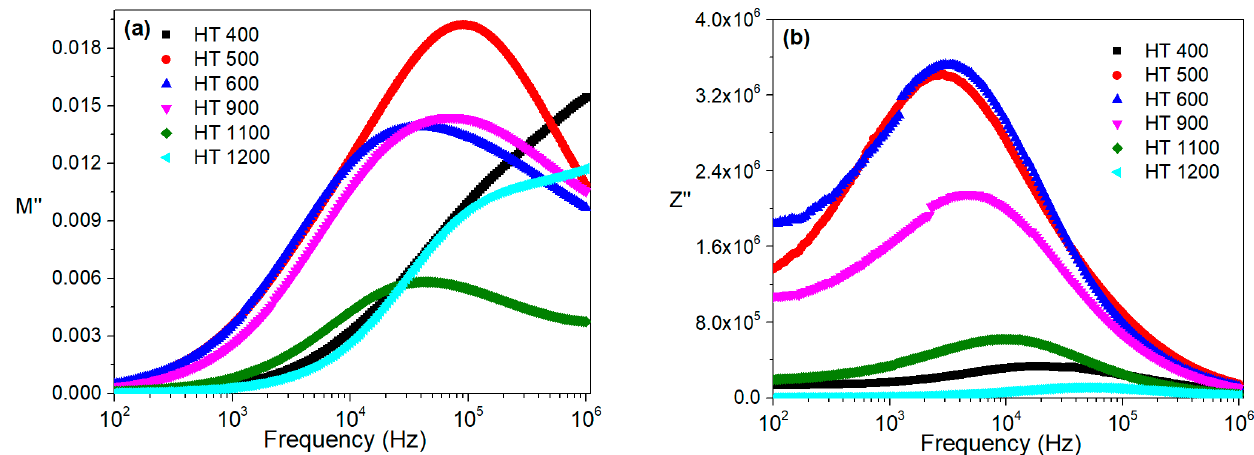
Figure 14. Frequency dependence of the imaginary parts of the ( a ) modulus and ( b ) impedance at room temperature for the samples prepared via the polymeric gel method.